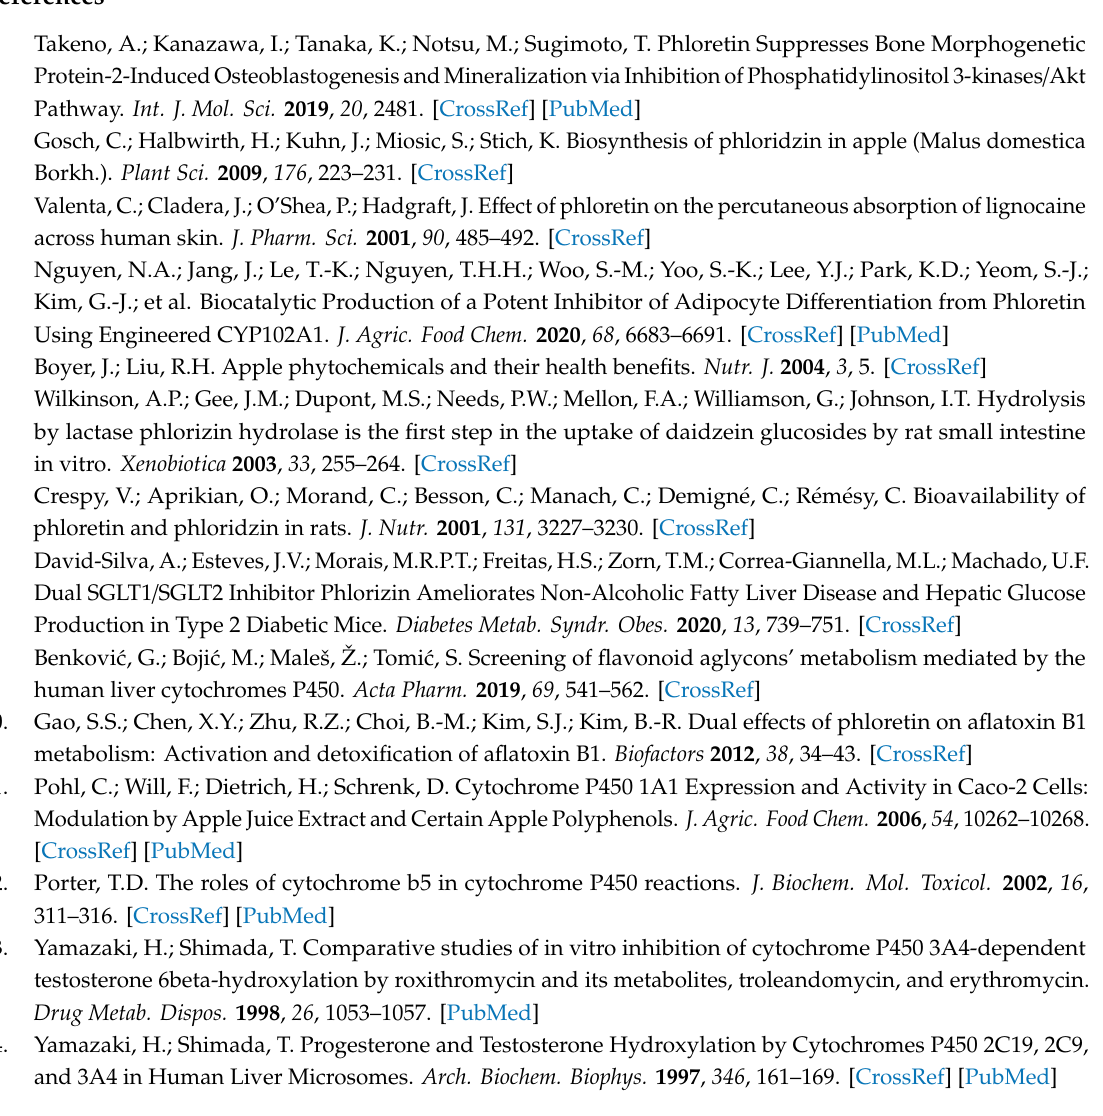
Figure S1. LC-MS analyses of the phloretin metabolite by HLMs; Figure S2. HPLC chromatograms of phloretin and its metabolites via HLMs, CYP3A4 and CYP2C19LC-MS analyses of the phloretin metabolite by CYP3A4; Figure S3. LC-MS analyses of the phloretin metabolite by CYP3A4; Figure S4. LC-MS analyses of the phloretin metabolite by CYP2C19; Figure S5. The kinetic parameters for 3-OH phloretin formation by human CYP3A4, CYP2C19, and HLMs; Figure S6. E ff ects of cytochrome b 5 on phloretin 3-hydroxylation by CYP3A4 and